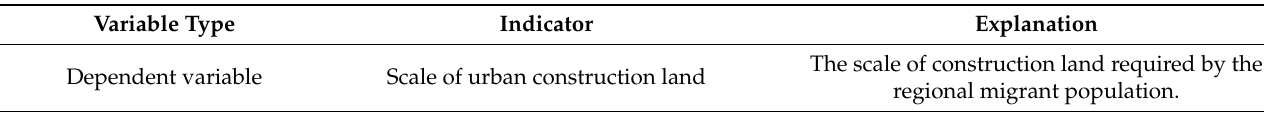
Table 2. Correlation factor analysis